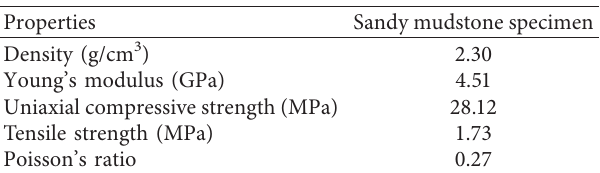
Table 2: Physical and mechanical parameters of sandy mudstone specimens.